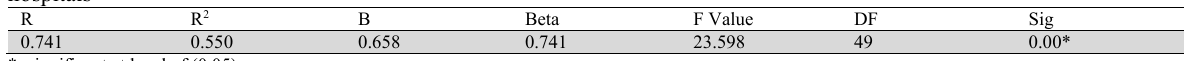
Simple regression to ensure the impact of medical invention marketing strategies on buying medical robot in the Jordanian hospitals R